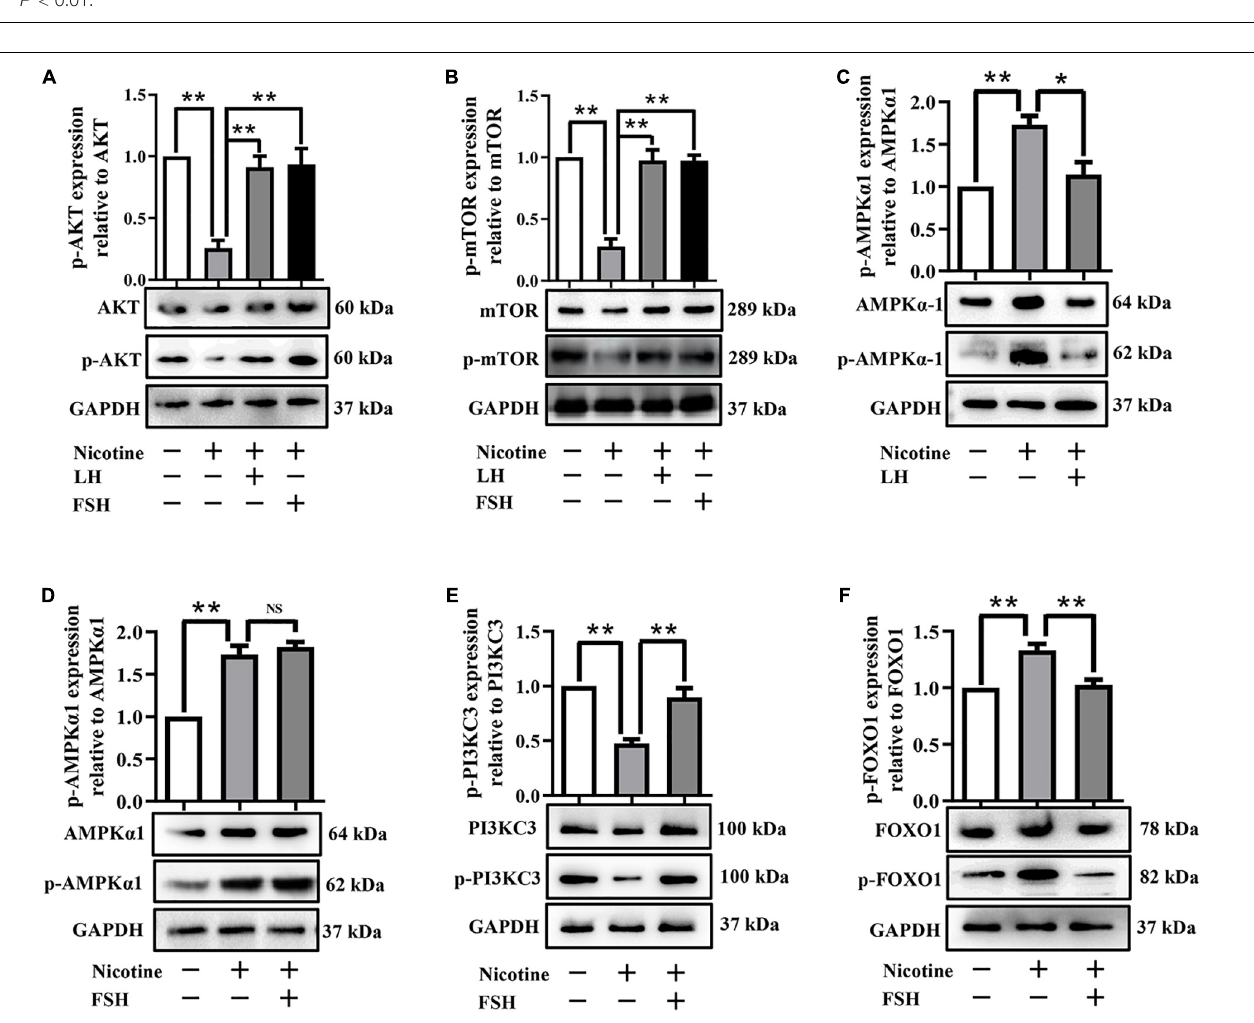
FIGURE 4 | LH or FSH alleviates nicotine-induced autophagy in ovarian cells in different ways. (A) p-AKT expression relative to AKT in the control, nicotine, nicotine plus LH, and nicotine plus FSH groups, respectively. (B) p-mTOR expression relative to mTOR in the control, nicotine, nicotine plus LH, and nicotine plus FSH groups, respectively. (C) p-AMPK α 1 expression relative to AMPK α 1 in the control, nicotine, nicotine plus LH, and nicotine plus FSH groups, respectively. (D) p-AMPK α 1 expression relative to AMPK α 1 in the control, nicotine, nicotine plus LH, and nicotine plus FSH groups, respectively. (E) p-PIK3C3 expression relative to PIK3C3 in the control, nicotine, nicotine plus LH, and nicotine plus FSH groups, respectively. (F) p-FOXO1 expression relative to FOXO1 in the control, nicotine, nicotine plus LH, and nicotine plus FSH groups, respectively, ( n = 72 newborn female pups in figure). The data are presented as means ± S.E. of three independent experiments (each in triplicate). * P < 0.05, ** P < 0.01, and ns P >